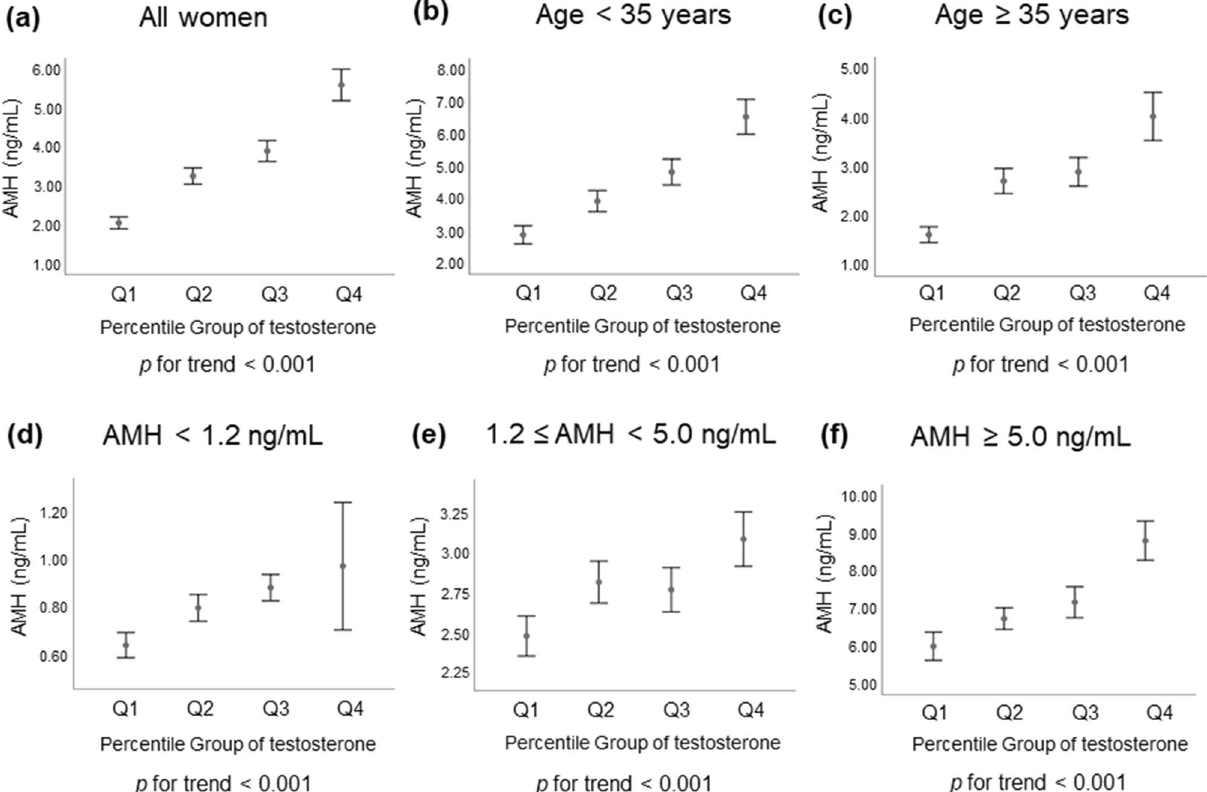
Figure 1. Serum AMH levels according to serum testosterone quartile categories in different groups. ( a ) all women, ( b ) age < 35 years, ( c ) age ≥ 35 years, ( d ) AMH < 1.2 ng/mL, ( e ) 1.2 ≤ AMH < 5.0 ng/mL and ( f ) AMH ≥ 5.0 ng/mL. The p values for the trends were generated using generalized linear models after adjustment for multivariate confounders. Multivariable confounders included age, weight, body mass index, and FSH. Error bar represented 95% confidence interval of AMH. AMH anti-Mullerian hormone, Q